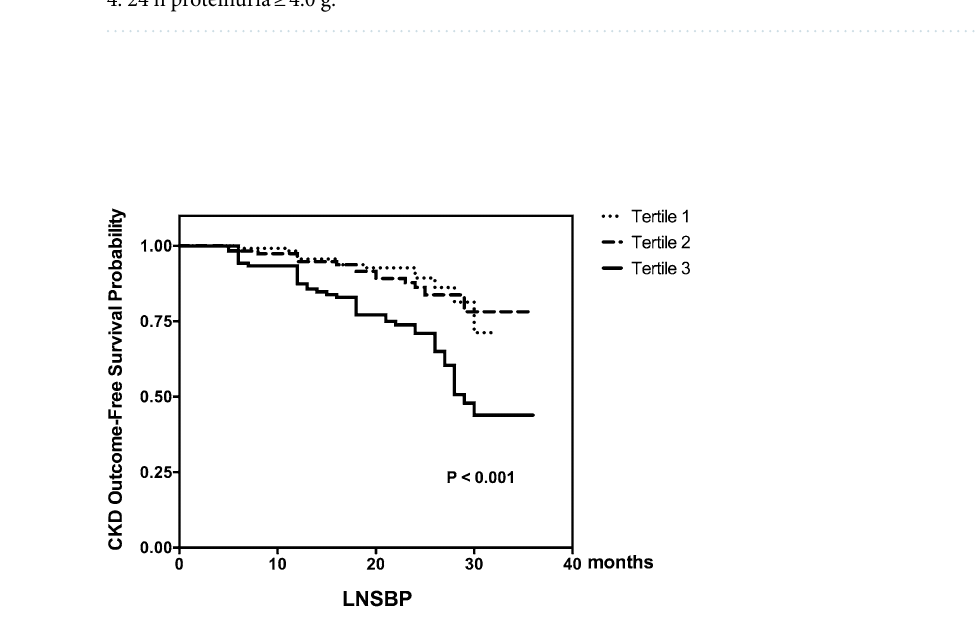
Figure 2. Kaplan–Meier analysis of composite outcome-free survival probability estimated by the lowest nocturnal systolic blood pressure. Kaplan–Meier curves stratified tertiles of the LNSBP. Time to events differed significantly between groups (log-rank P <